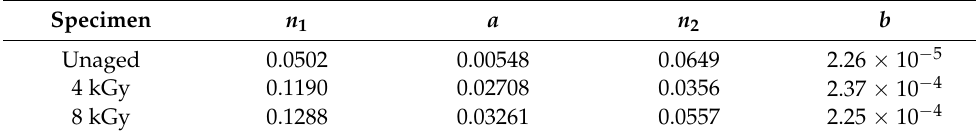
Figure 9. ( a ) Initial charge density just before depoling and ( b ) mean lifetime of space charge decay of gamma irradiated samples. Table 2. Modelling parameters of mean magnitude of charge density during depoling time.